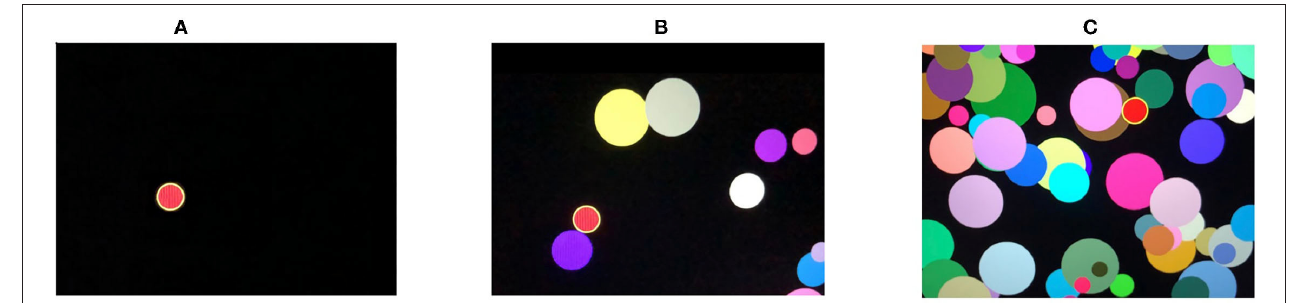
FIGURE 3 | Attention study and interference resilience technique (for details see Subsection